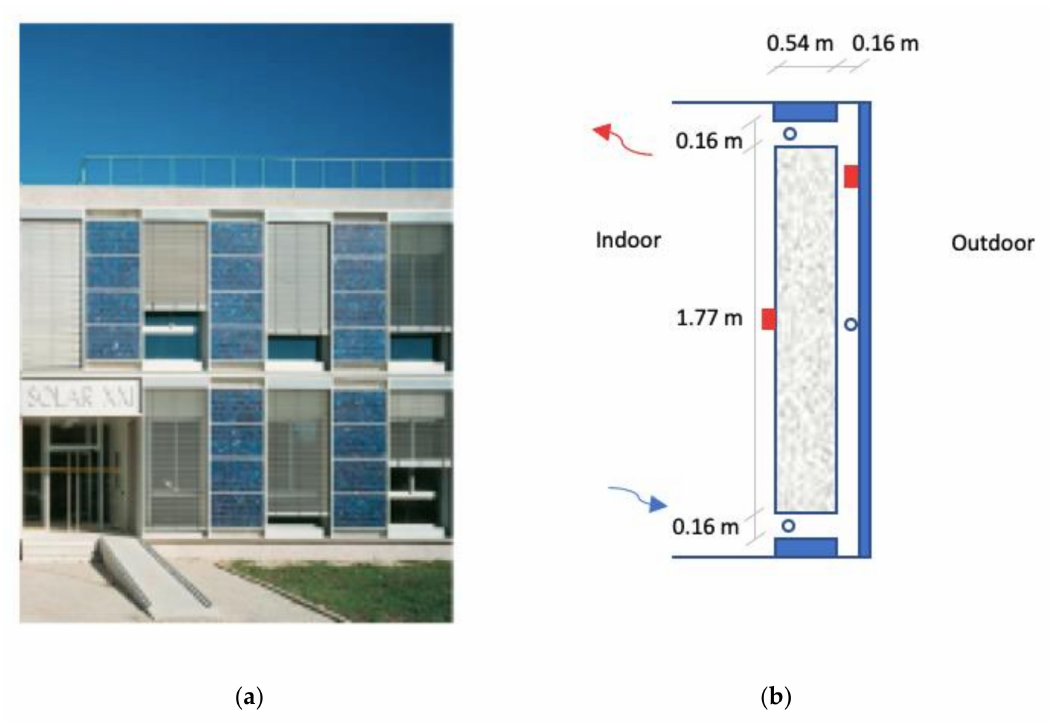
Figure 2. ( a ) Front view of the BIPVT systems in the Solar XXI building, ( b ) cross-section and dimensions.